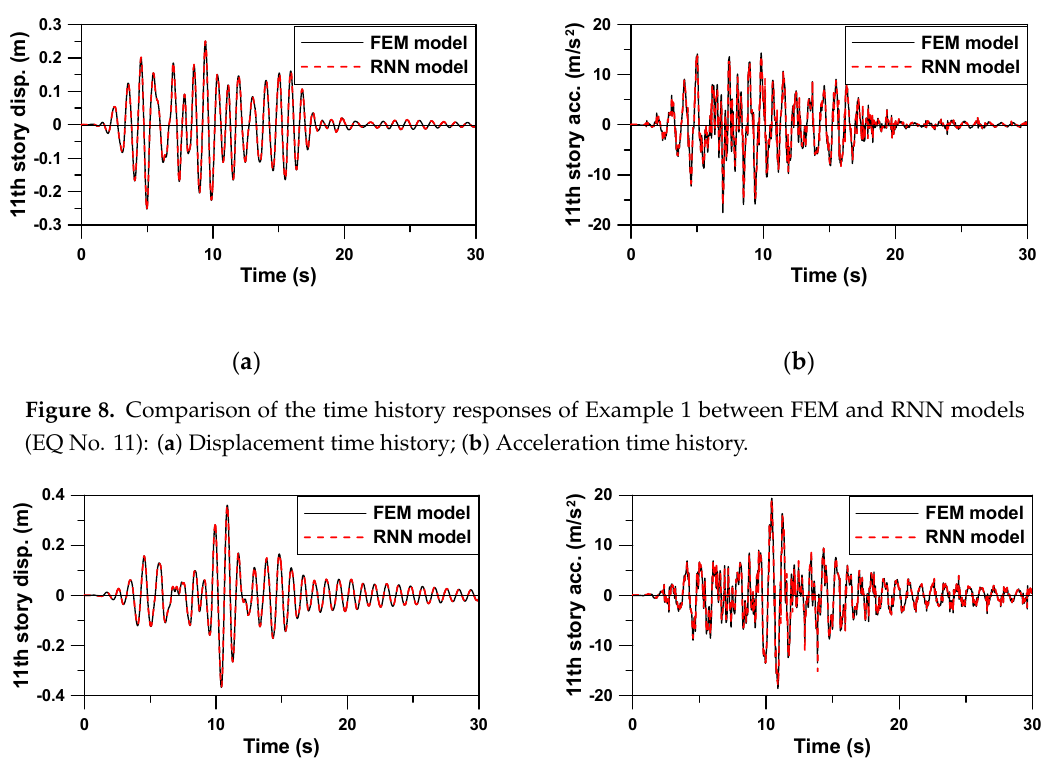
Figure 7. RMSE variation versus epoch of RNN model for Example 1.